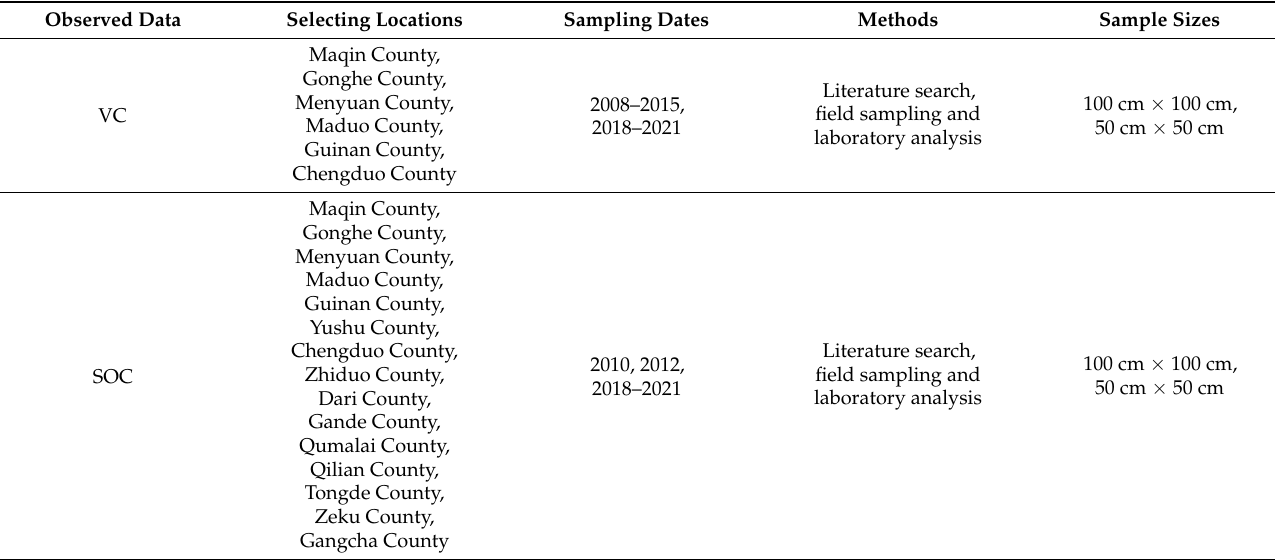
Table A2. The sources of the observed VC and